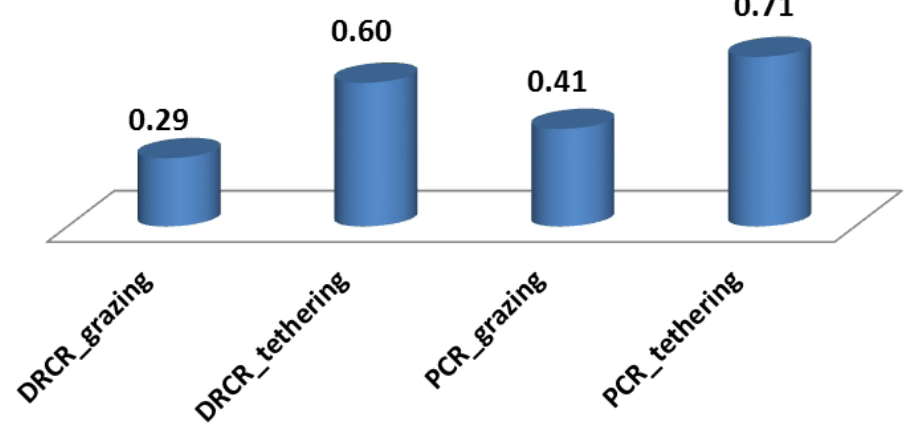
Figure 3: Values of PCR and DRCR of small-scale beef farming on grazing and tethering systems at upstream area of Benain-Noelmina